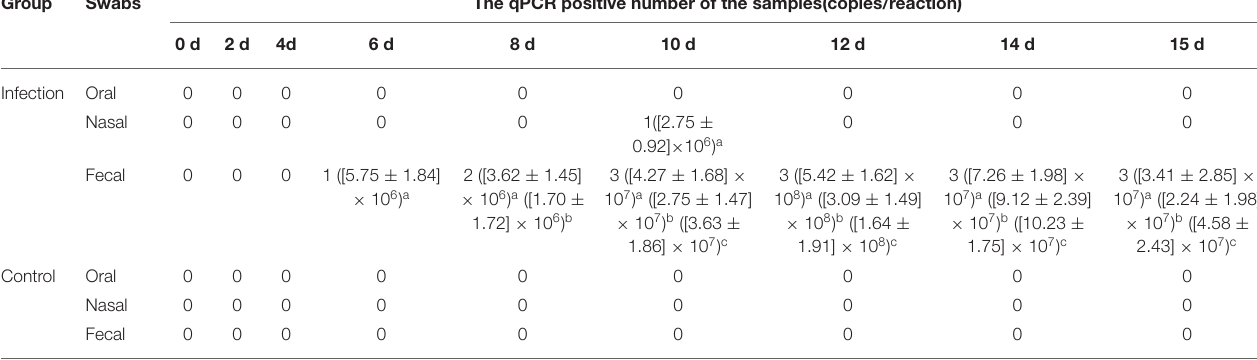
TABLE 6 | Detection of the CanineCV DNA by qPCR in the experimental infection. Group Swabs The qPCR positive number of the samples(copies/reaction)